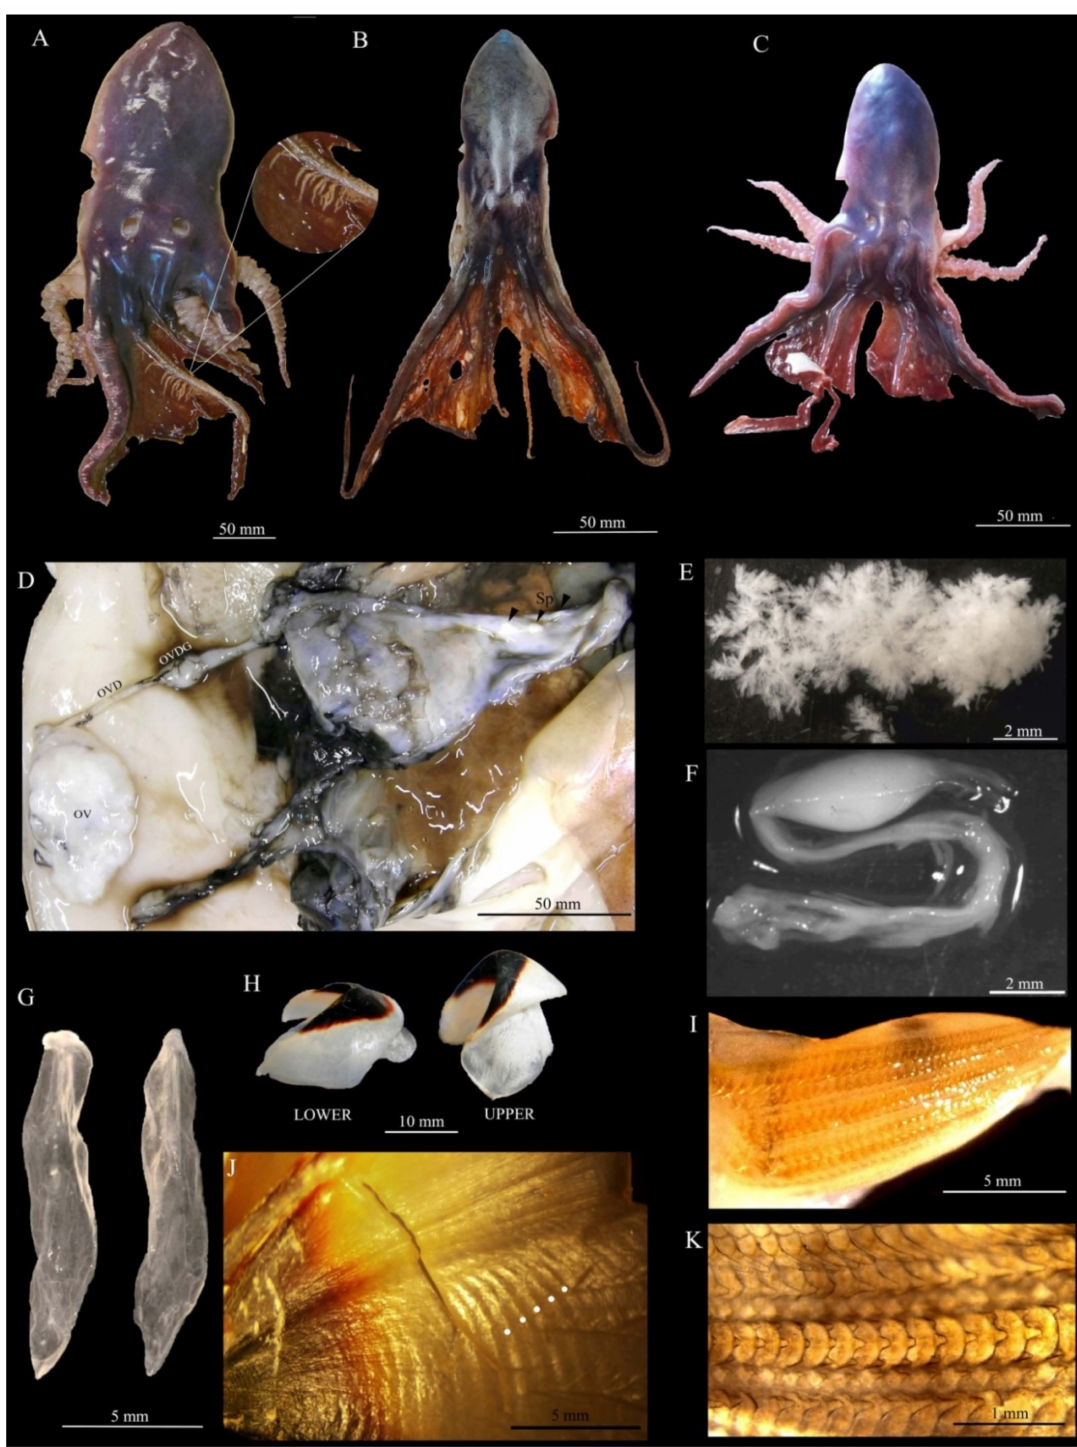
Figure 1. Tremoctopus violaceus from the Mediterranean Sea. Photographic records of the three females TV11 ( A ), TV16 ( B ), and TVBA ( C ) are shown. The magnified circle in ( A ) shows patches forming clusters arranged transversely in a piece of the web. Mantle cavity ( D ), ovary oocytes ( E ), and spermatangia ( F ) from TV11 are shown. Stylets from TV16 ( G ), upper and lower beak from TV11 ( H ), increments marked by points ( J ), and radula ( I , K ) from TV16 are shown. Abbreviations: OV, ovary; OVD, ovidutcts; OVDG, oviducal gland; Sp,